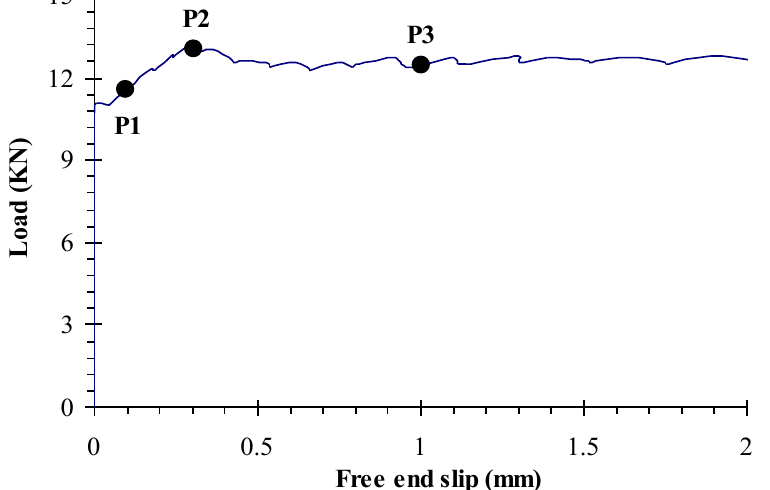
Figure 10. Definition of pullout loads corresponding to bond strength comparisons.